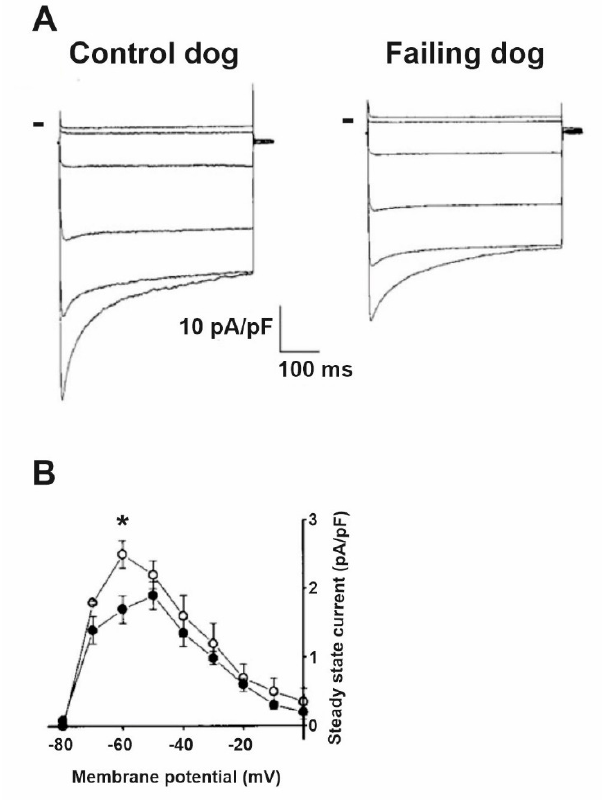
Figure 4. I K1 is downregulated in heart failure. ( A ) Representative current traces from control and failing dog ventricular myocytes using voltage steps between − 150 mV and − 50 mV using 20 mV increments. Peak and steady-state currents are reduced in failing myocytes. Small bars indicate zero current level. ( B ) The averaged steady-state current–voltage relation shows significantly reduced I K1 current density in failing myocytes (filled circles) compared to control (open circles) at − 60 mV membrane potential [11] . * p < 0.05 vs control myocytes at − 60 mV.